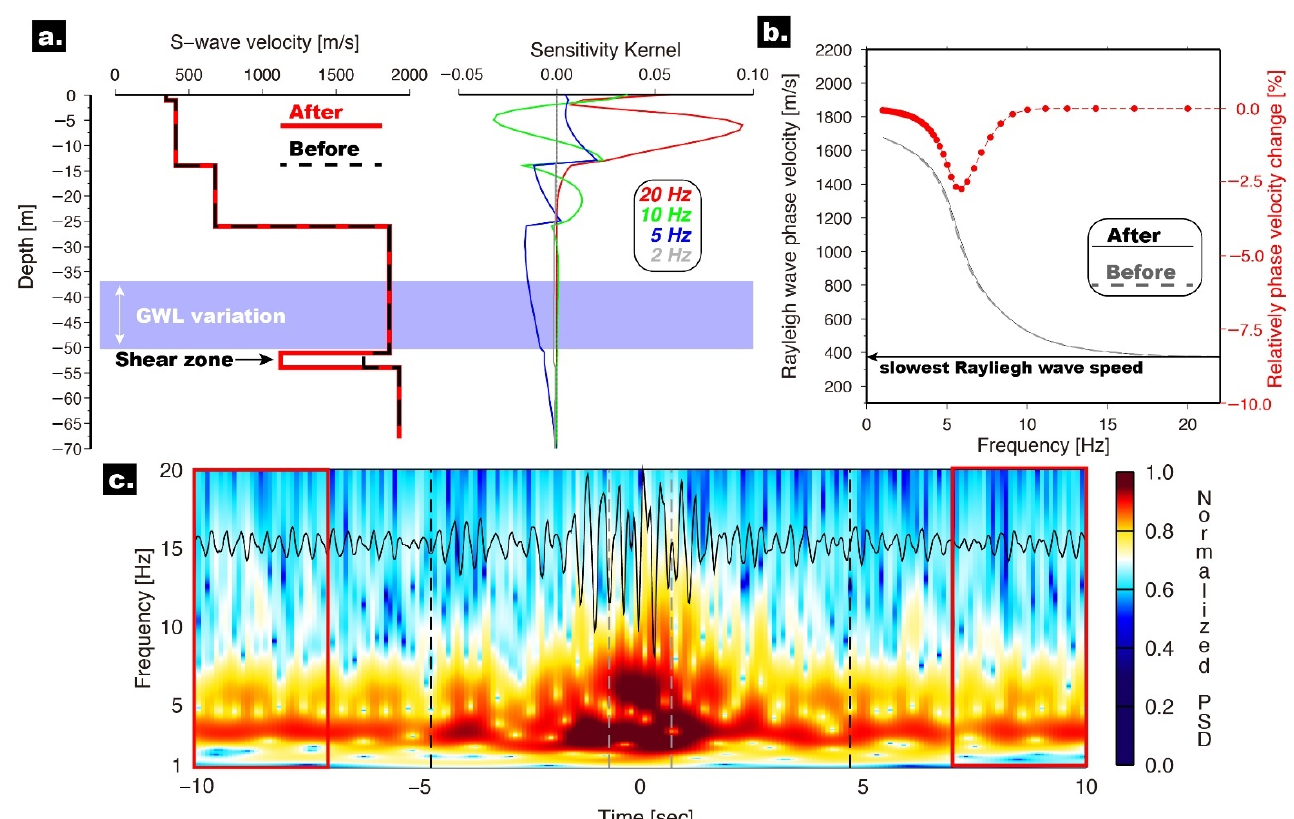
Figure 2. Shear-wave velocity and sensitivity and phase velocity of a surface wave: ( a ) Left: The v s model before (dashed line) and after (solid line) applying a velocity reduction of 67%. Right: Sensitivity kernels of Rayleigh wave phase velocity at selected frequencies of 2, 5, 10, and 20 Hz computed with the initial layer model of shear-wave velocity ( v s ); ( b ) Two dispersion curves obtained using initial and perturbed models. The red line indicates the relative velocity changes corresponding to the basal layer of sliding material; ( c ) Spectrogram of the reference noise cross-correlation function (RNCF). The gray and black vertical dashed lines indicate the arrival times related to the fastest and slowest Rayleigh waves between the station pair of SP1–SP2. The black trace shows the RNCF. The red rectangle depicts the time window of the coda wave used to calculate the dv/v .